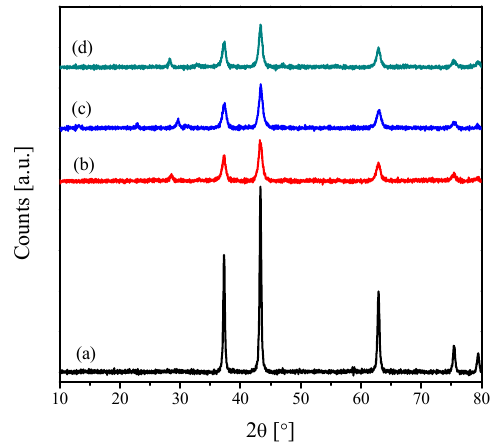
Figure 2. XRD diffractograms of the calcined Ni-oxalate ( a ); Gd/Ni-oxalate ( b ); La/Ni-oxalate ( c ); and Sm/Ni-oxalate ( d ). Table 1. Some physical properties for the bare NiO and RE-promoted NiO catalysts.